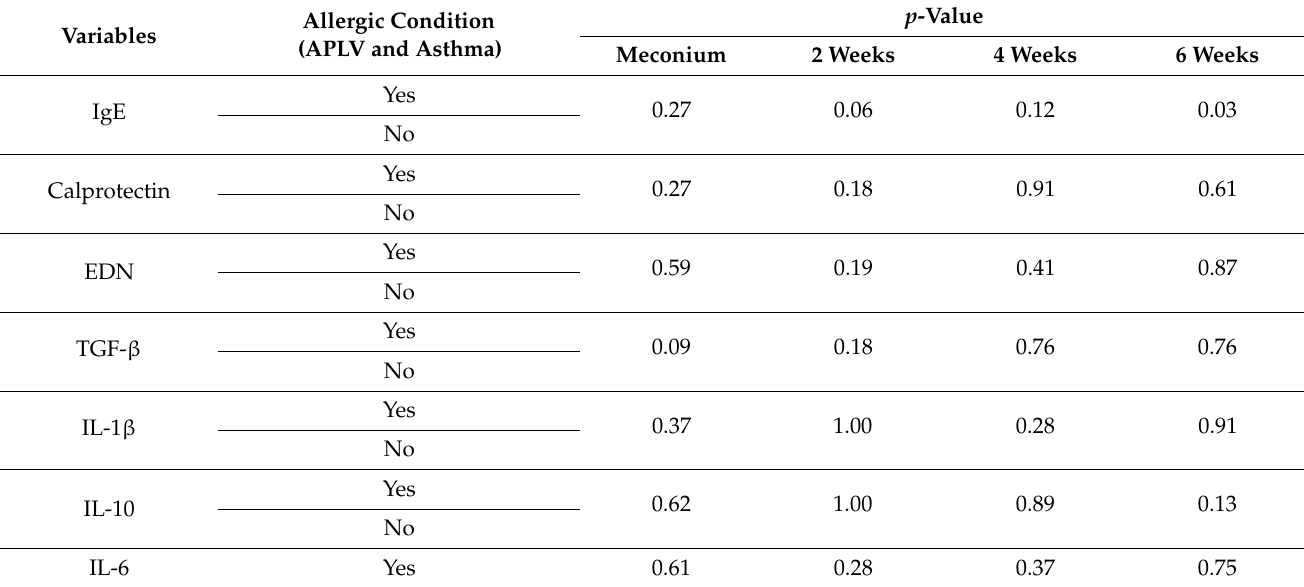
Table 3. Comparison of mediators and cytokines and the occurrence or absence of an atopic condition between years 0 and 1. Statistical test used: Wilcoxon